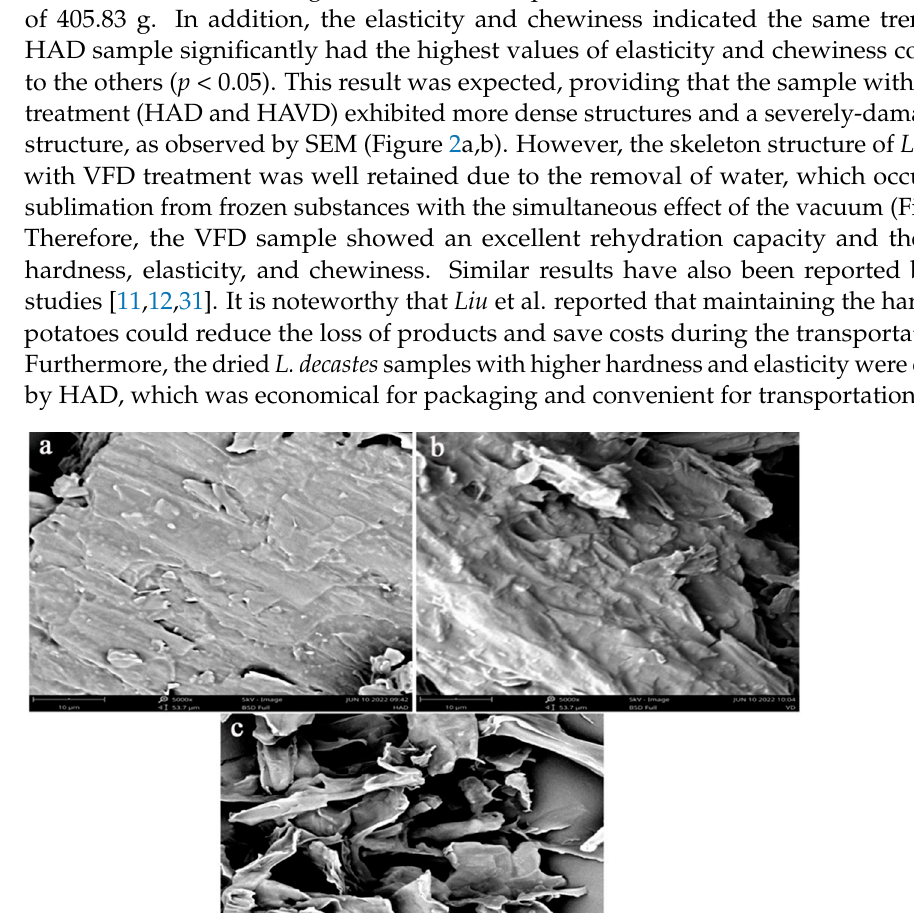
Figure 3. The fingerprints of the volatile flavor compounds of L. decastes under different drying methods, as determined by GC-IMS: ( a ) difference topographic plot, ( b ) gallery plot. HAD: hot-air- drying sample; HAVD: hot-air-combined-with-vacuum-drying sample; VFD: vacuum-freeze-dry- ing sample.